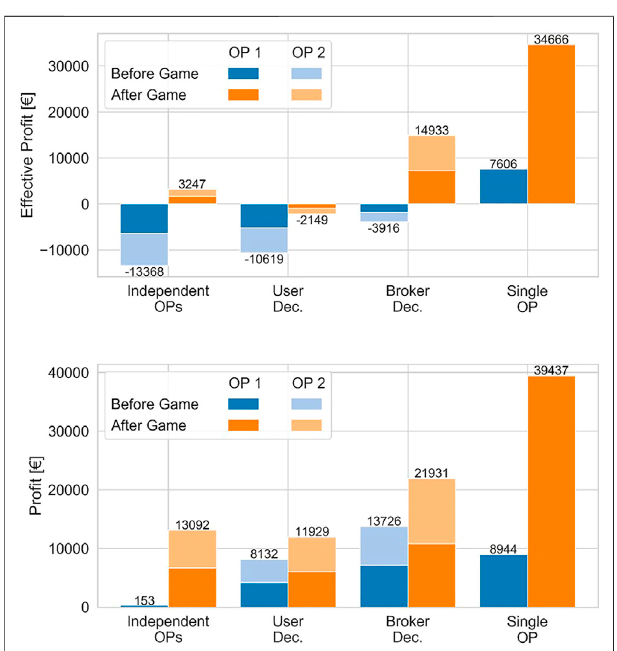
FIGURE 9 | Effective Pro fi t (top) and Pro fi t (bottom) before and after the game for the different interaction